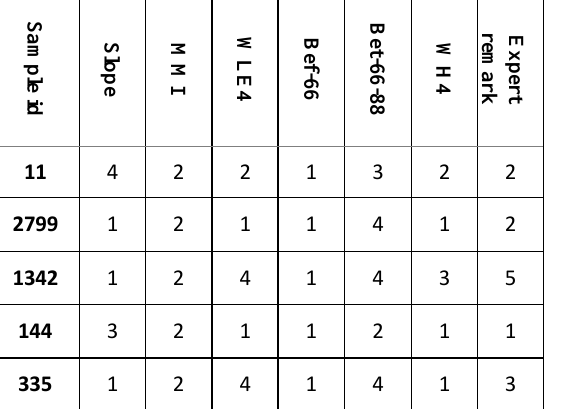
Figure 3. Scatter plot of the input criteria showing the correlation of each criteria